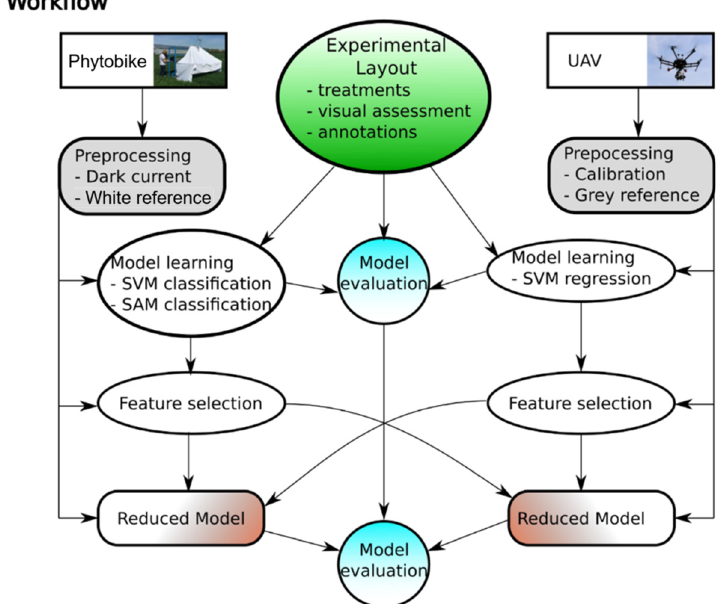
Figure 4. Underlying workflow of data assessment to compare different prediction algorithms and evaluate the value of information about selected features at different scales. SVM = support vector machine, SAM = spectral angle